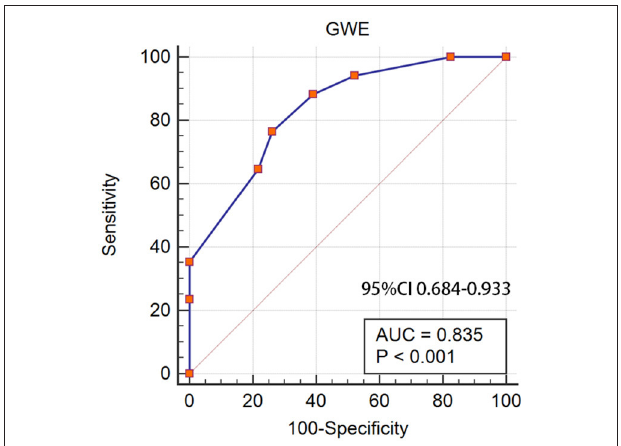
FIGURE 5 | GWE as a prognostic factor of CAEs in patients with MM. GWE, global work efficiency; CAEs, cardiac adverse events; MM, multiple